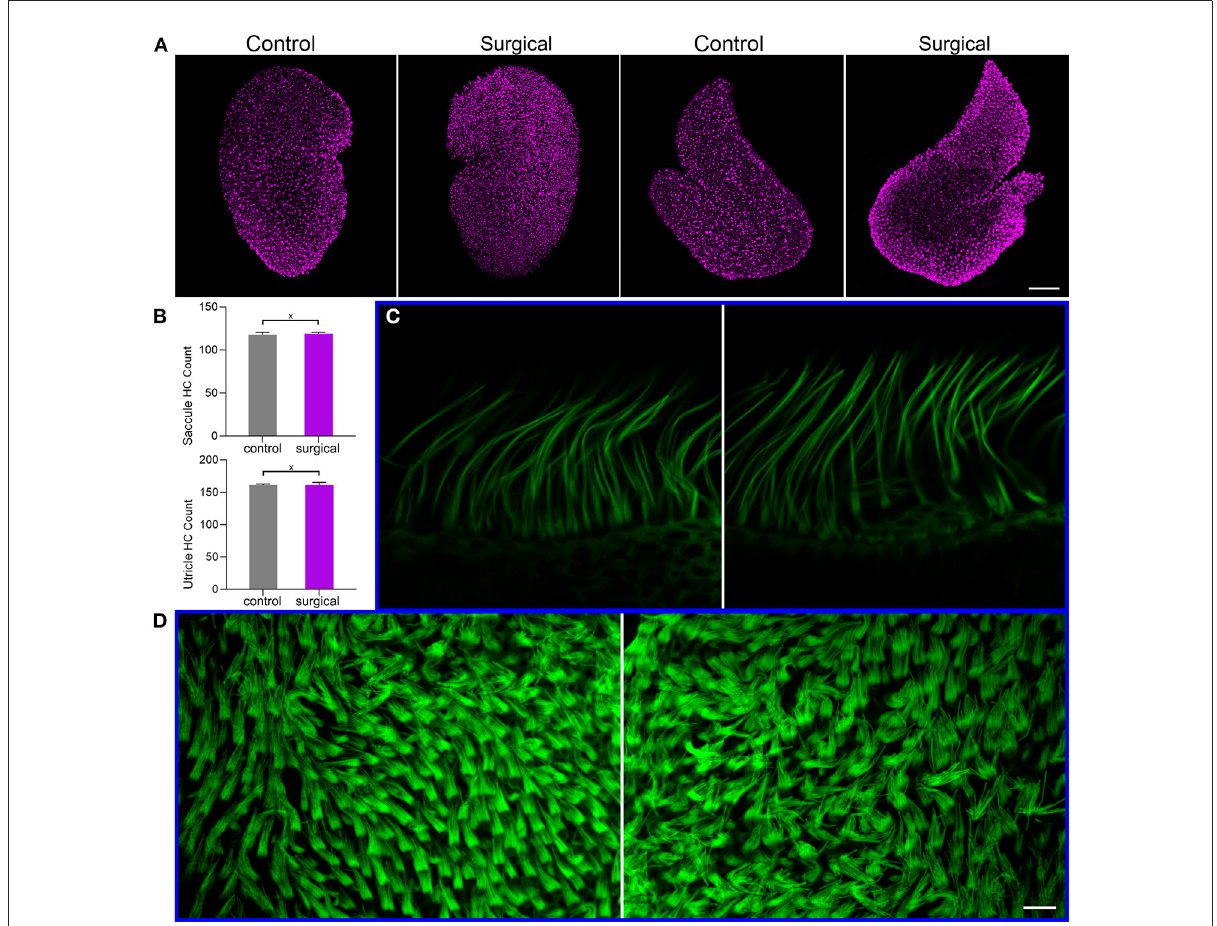
FIGURE3 Hair cell and stereocilia status after occlusion of lateral-posterior semicircular canals. (A) Confocal images of utricle and saccule hair cells in control and surgical ears. Hair cells were labeled with anti-MYO7A antibody. Bar: 75 µ m. (B) Hair cell count in utricle and saccule of control and surgical ears. X marks no statistical significance between control and surgical ears ( p = 0.35 and 0.48 for saccule and utricle hair cell count, respectively). Data are presented as the mean ± SD, n = 3. (C) Confocal images of stereocilia bundles of crista hair cells from control (left panel) and surgical (right panel) ears. (D) Confocal images of utricle hair cell stereocilia control (left panel) and surgical (right panel) ears. Bar: 10 µ m for (C,D)